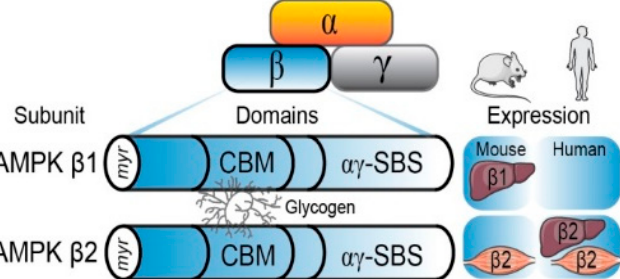
Figure 1. The AMPK is a heterotrimeric protein, consisting of a catalytic α subunit and regulatory β and γ subunits. The β subunit ( β 1 and β 2 isoforms) possesses a glycogen-binding domain (CBM) that mediates AMPK’s interaction with glycogen, an N-terminal myristoylation site (myr) and an αγ subunit binding sequence ( αγ -SBS) involved in the heterotrimeric complex formation. Tissue expression of the β 1 and β 2 isoforms varies between humans and mice, as the β 2 isoform is predominately expressed in both human liver and skeletal muscles, while mice predominately express the β 1 isoform in the liver and the β 2 isoform in the skeletal muscles.